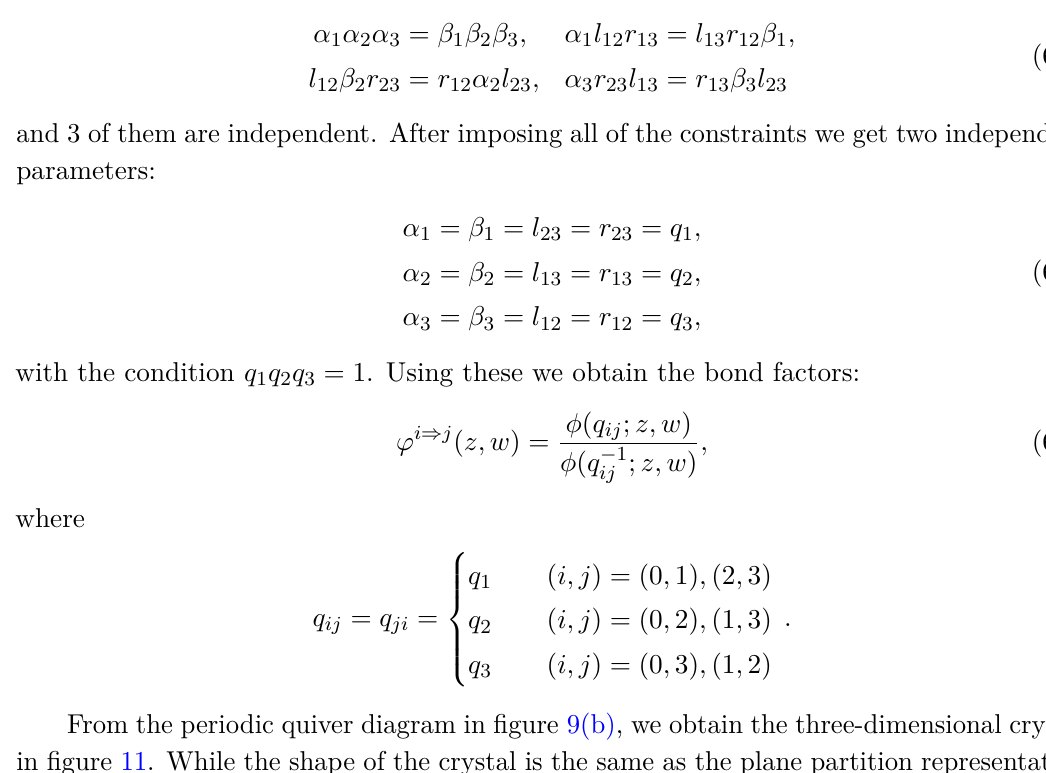
(a) Quiver diagram. Figure 10. Quiver diagram and Dynkin diagram of affine superalgebra the simple roots to be